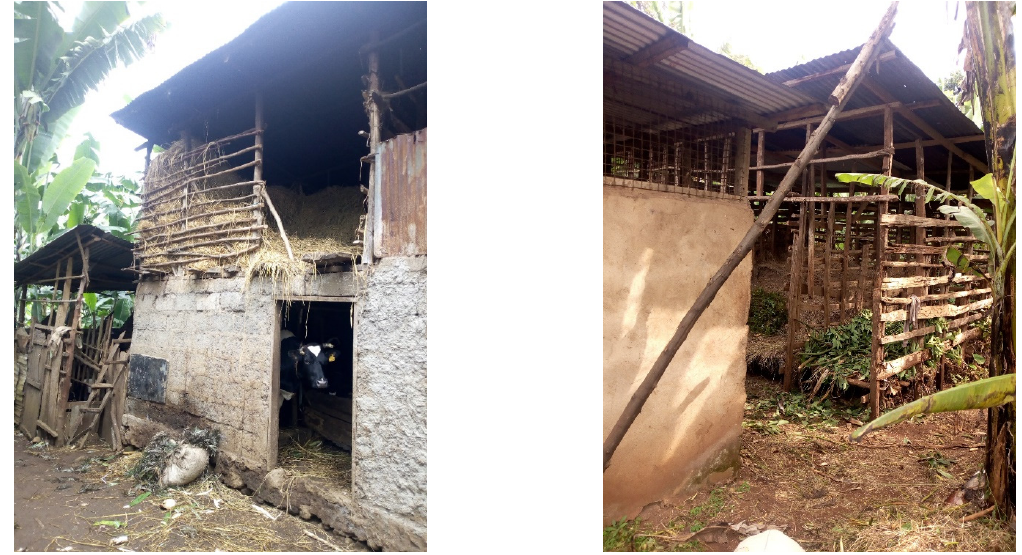
Figure 6. Feed conservation practices in smallholder dairy cattle farming systems.